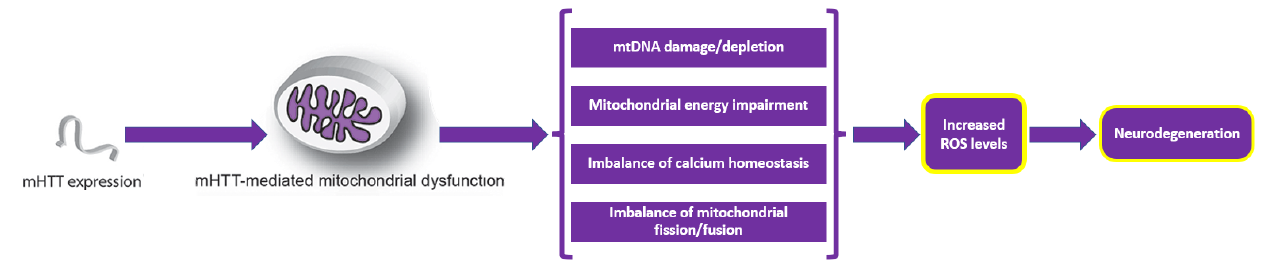
Figure 6. Mutant HTT (mHTT)-induced mitochondria-mediated reactive oxygen species (ROS) accumulation. Adapted from [62].